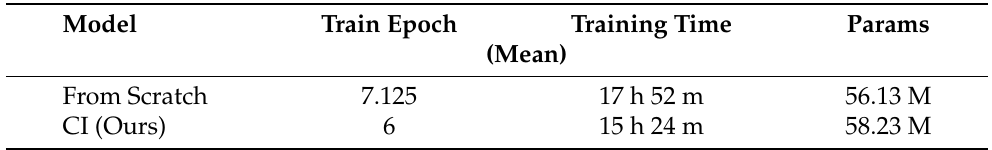
Table 3. Training cost evaluation of vanilla image captioning models. Training eight times for each